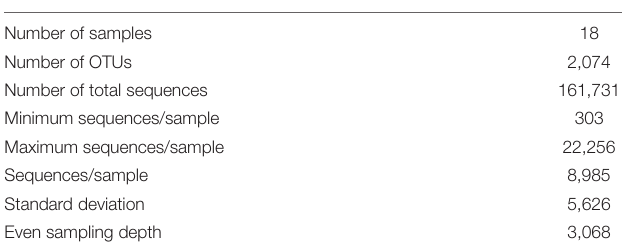
TABLE 2 | 454 pyrosequencing